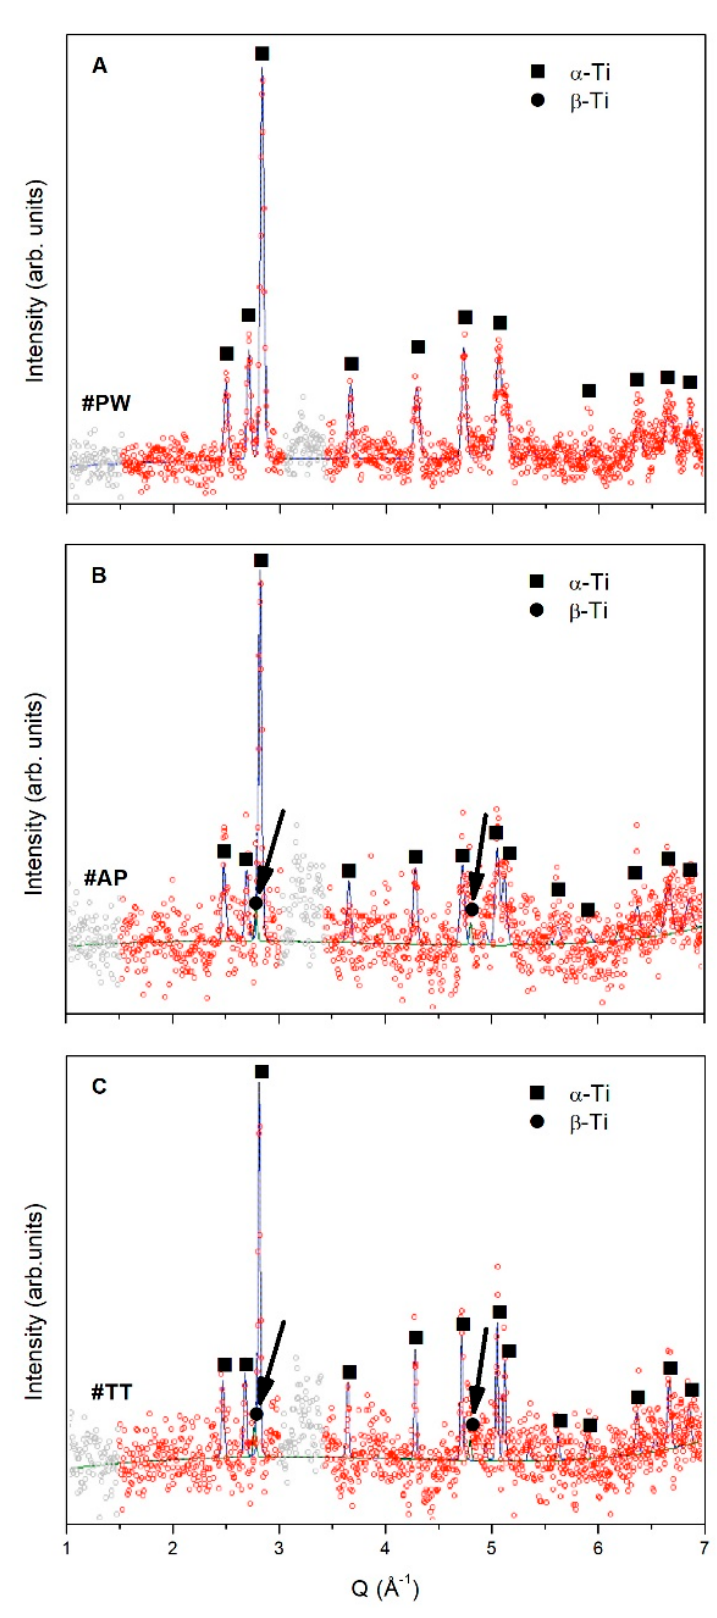
Figure 2. ND patterns of samples: ( A ) powder (#PW), ( B ) as-produced (#AP) and ( C ) thermal-treated (#TT). Experimental data points: red dots; Rietveld refining: continuous line. Gray regions of patterns are excluded Q ranges due to instrument background. Full square: α -Ti; Full dots: β -Ti. Arrows indicate peak position of the β -Ti phase.